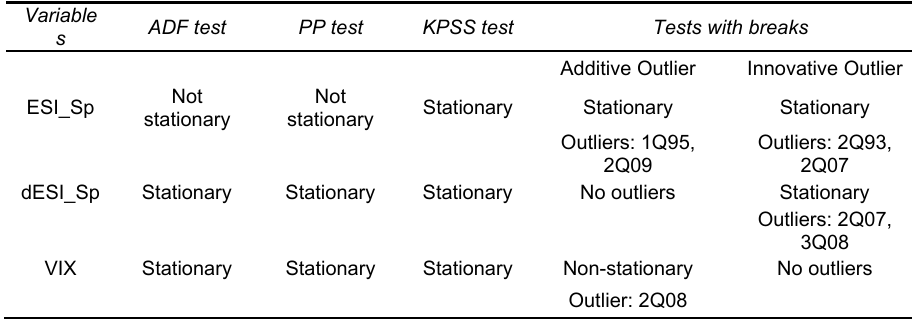
Table 2. Results of unit root